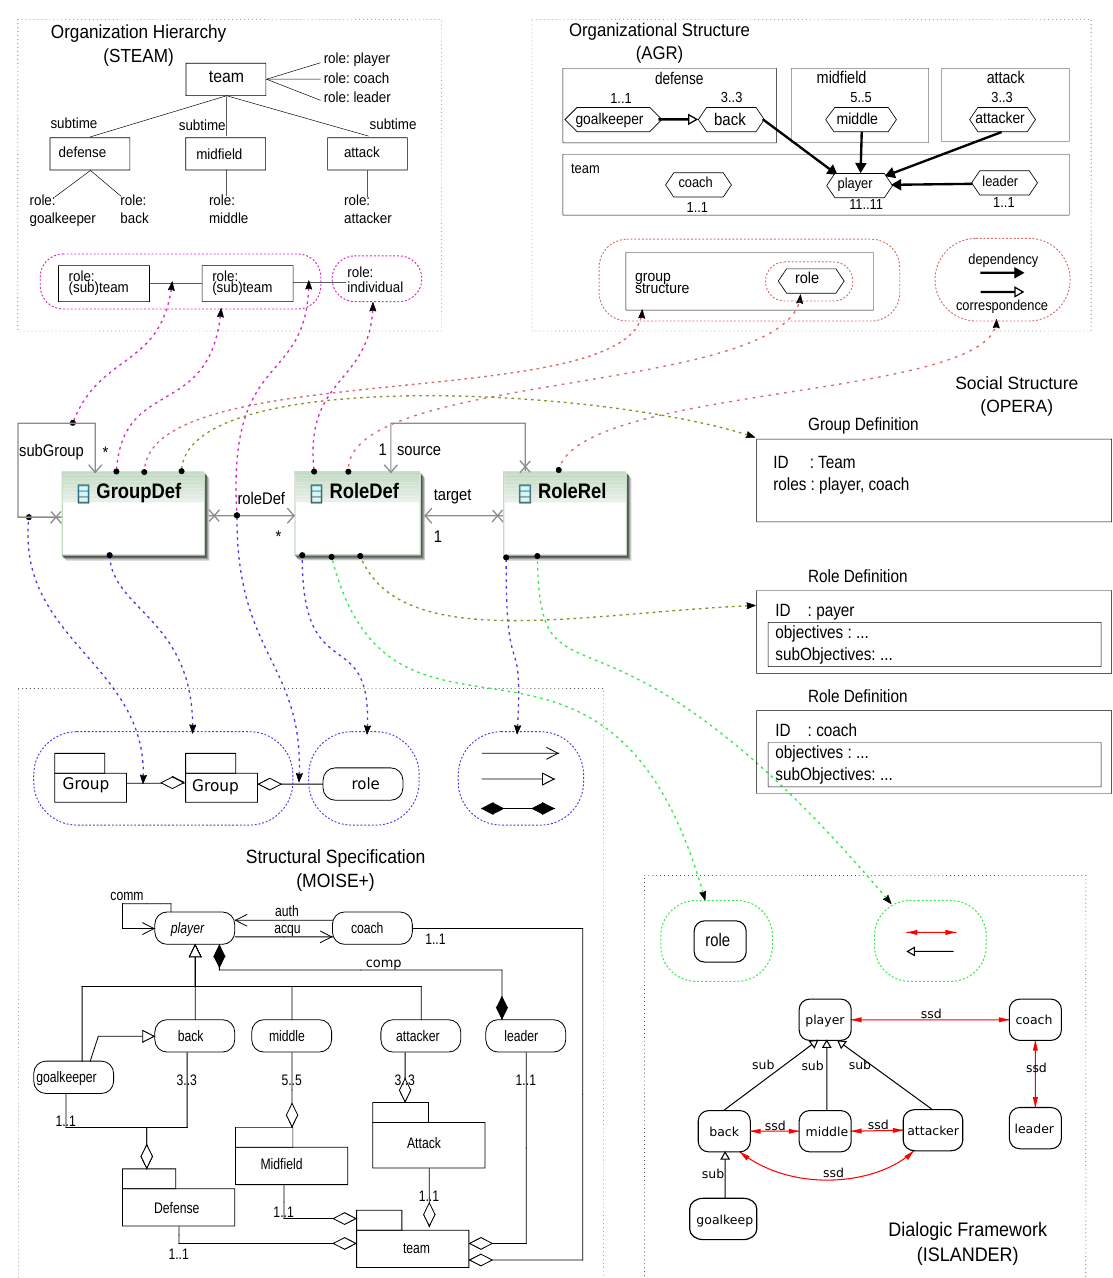
Figure 3. Similar structural specifications written in STEAM, AGR, OPERA, MOISE+ and ISLANDER, for a team of agents part of a simulated soccer game (example taken from [24,25]). The team is composed of eleven players (one goalkeeper , three backs , five mid-filders and three attackers ) and one coach , and is divided in three groups: Defense , midfield and attack . The class diagram (Ecore metamodel) in the center of the figure represents the conceptual pattern identifiable in the various approaches of structural modeling. The dotted arrows detail what concepts are captured by what classes of the